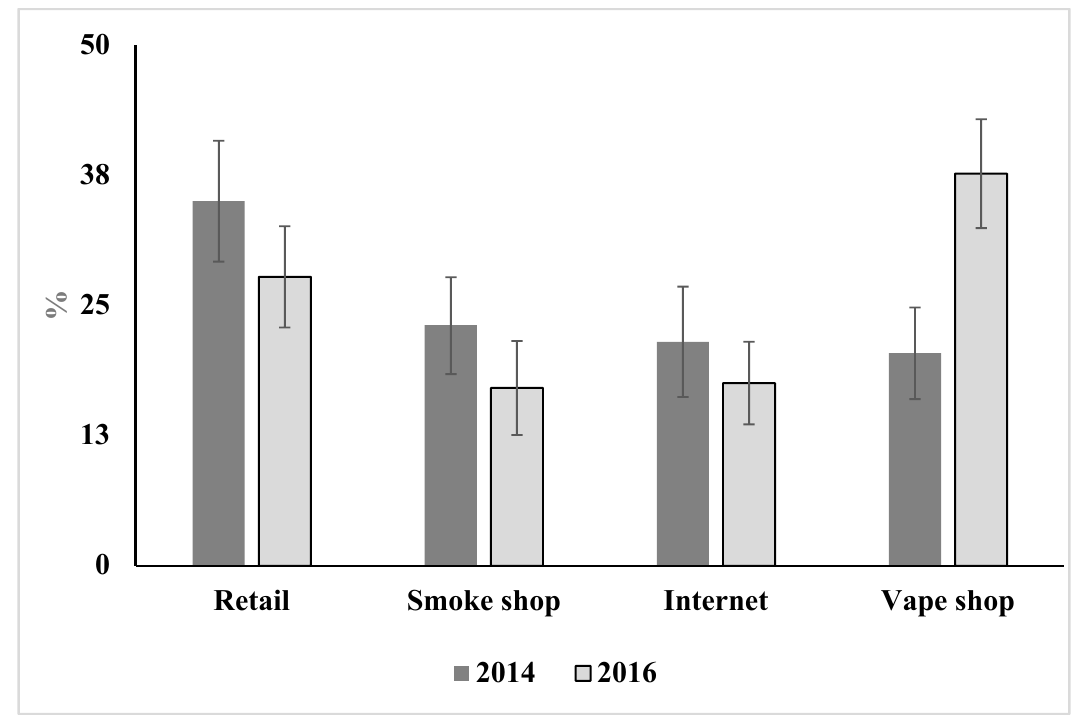
Figure 2. The changing market share, based on e-cigarette users’ self-report, from 2014 to 2016.